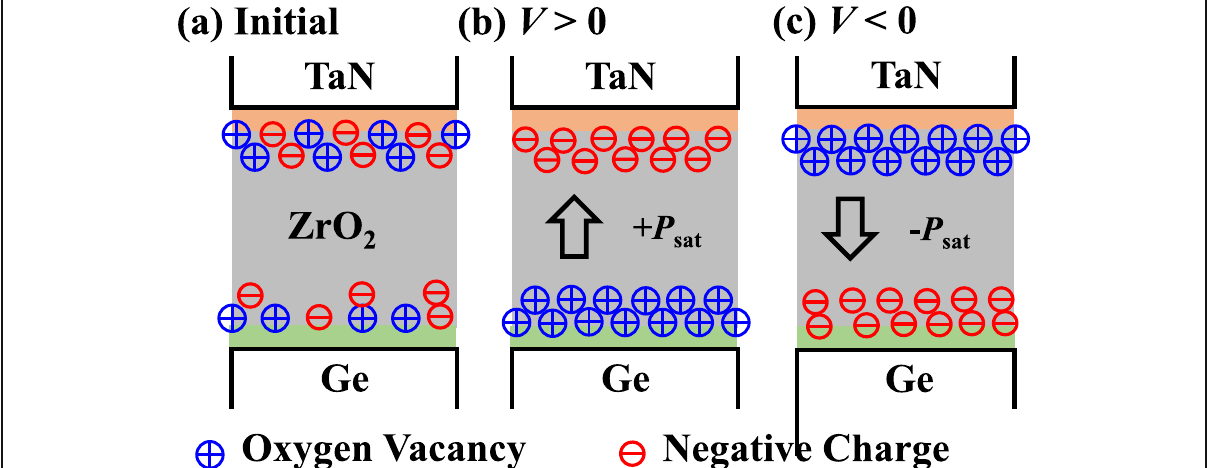
Fig. 5 Schematics of the mechanism for switchable P in ZrO 2 capacitors, which is attributed to the migration of voltage-driven oxygen vacancies and negative charges to form dipoles